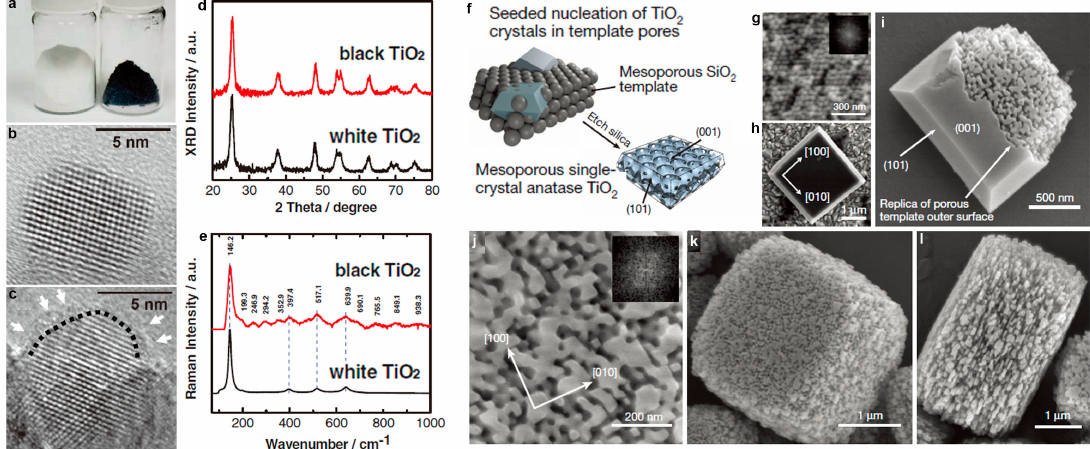
Figure 3. Post treatment route to tune the surface/interface structures in TiO 2 materials. ( a ) A photo comparing unmodified white and disorder-engineered black TiO 2 nanocrystals; ( b , c ) High-resolution transmission electron microscopy (HRTEM) images of TiO 2 nanocrystals before and after hydrogenation, respectively. In ( c ), a short dashed curve is applied to outline a portion of the interface between the crystalline core and the disordered outer layer (marked by white arrows) of black TiO 2 ; ( d , e ) X-ray Diffraction (XRD) and Raman spectra of the white and black TiO 2 nanocrystals (reprinted from [49] with permission, Copyright American Association for the Advancement of Science, 2011). ( f ) Schematic and ( g – l ) electron microscopy images of mesoporous single-crystal nucleation and growth within a mesoporous template. ( g ) Pristine silica template made up of quasi-close-packed silica beads; ( h ) non-porous truncated bipyramidal TiO 2 crystal; ( i ) template-nucleated variant of the crystal type shown in ( h ); ( j ) replication of the mesoscale pore structure within the templated region; ( k , l ) fully mesoporous TiO 2 crystals grown by seeded nucleation in the bulk of the silica template. (Reproduced with permission from [44], Copyright Nature Publishing Group, 2013).